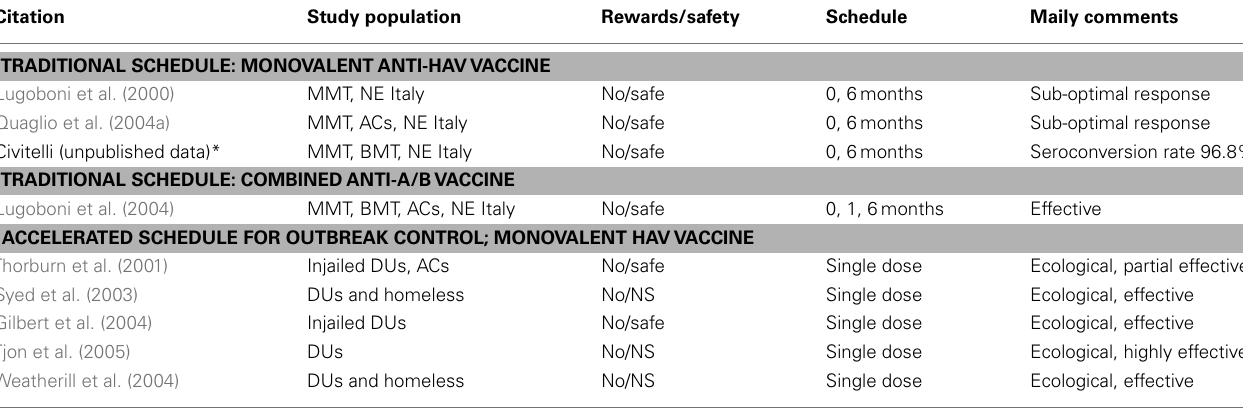
Table 2 | HepatitisA virus vaccine among